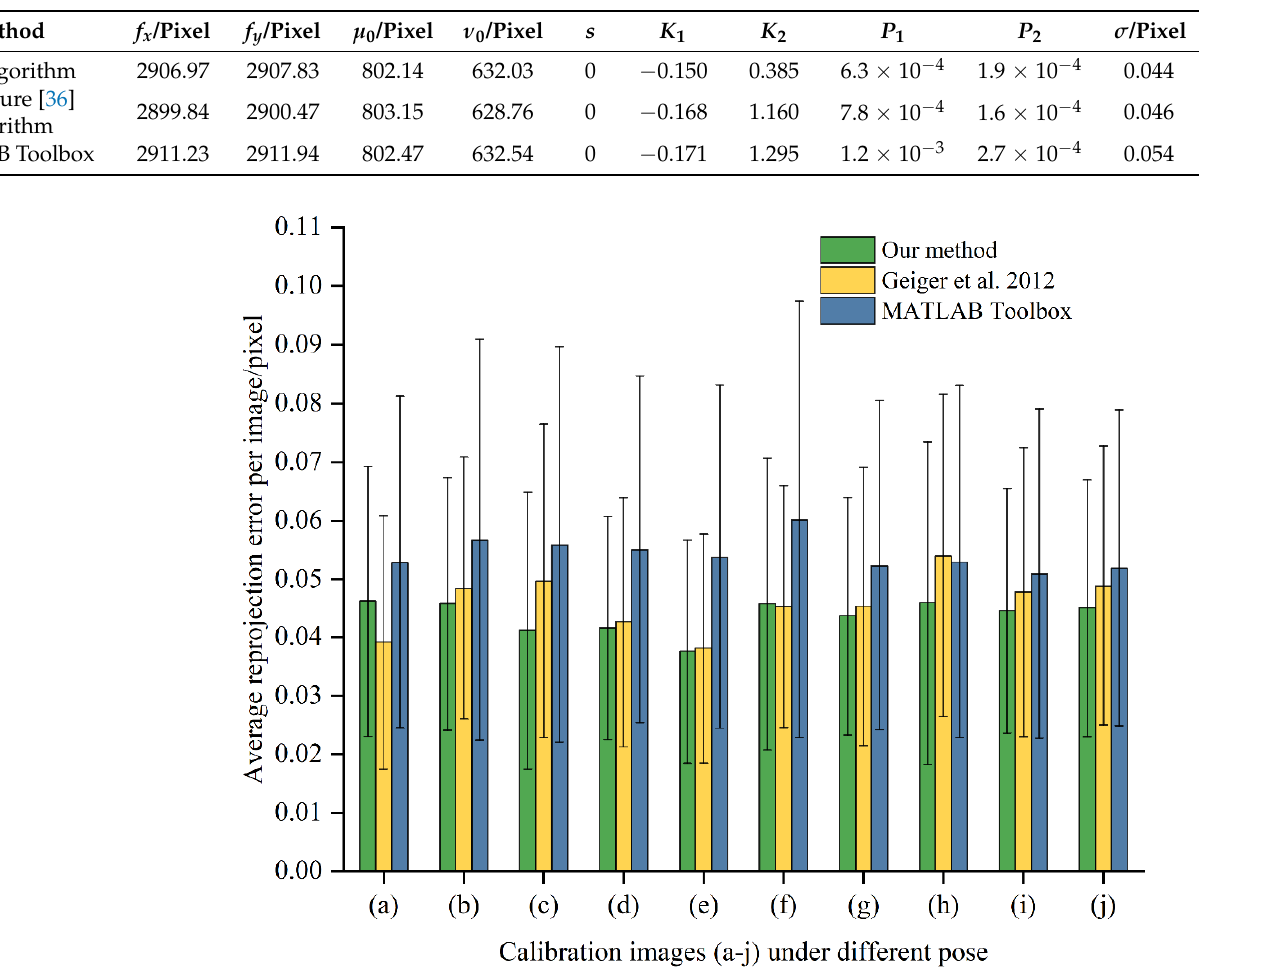
Figure 12. Comparison of reprojection error with literature [36] and MATLAB toolbox.